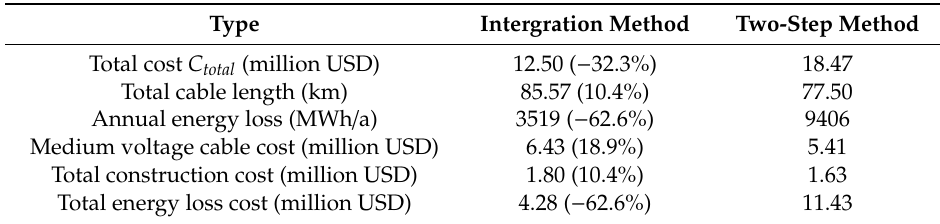
Table 3. Summary of total cable usage and cost (references for the % are the values obtained by the two-step Figure 10. Comparison of lengths of different cross-sectional cables used in the topology.